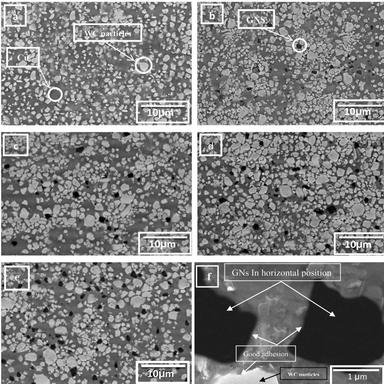
SEM micrographs of (a) 0 wt% graphene (b) 0.25 wt% graphene (c) 0.5 wt% graphene (d) 0.75 wt% graphene (e) 1 wt% graphene sintered nano-composite and (f) for 1 wt% GNs to show the position of GNs and adhesion between it and copper.